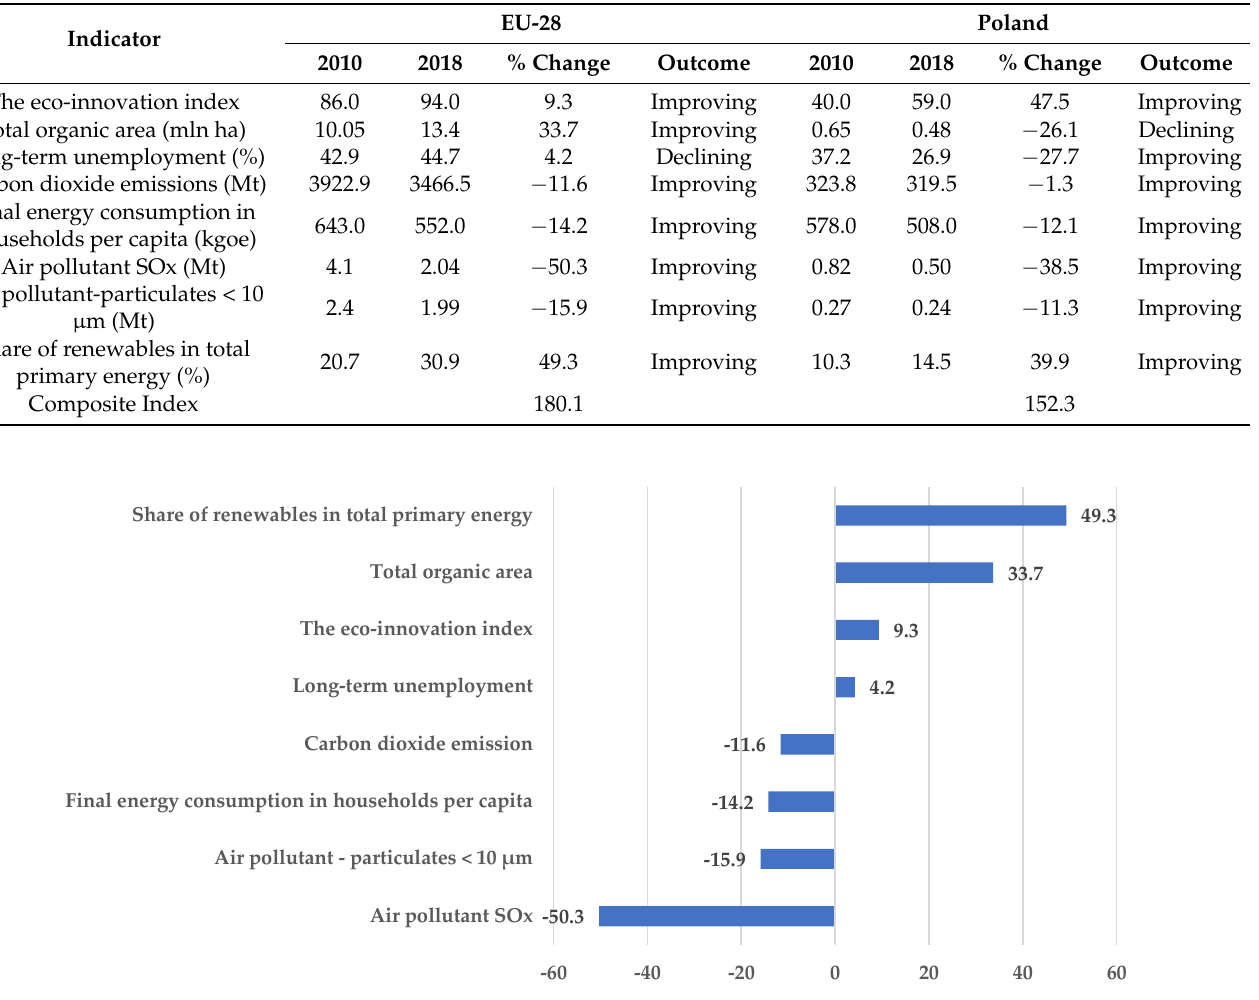
Figure 6. Net change (%) in SDG indicators, EU-28, 2010–2018. Own study, based on [31].